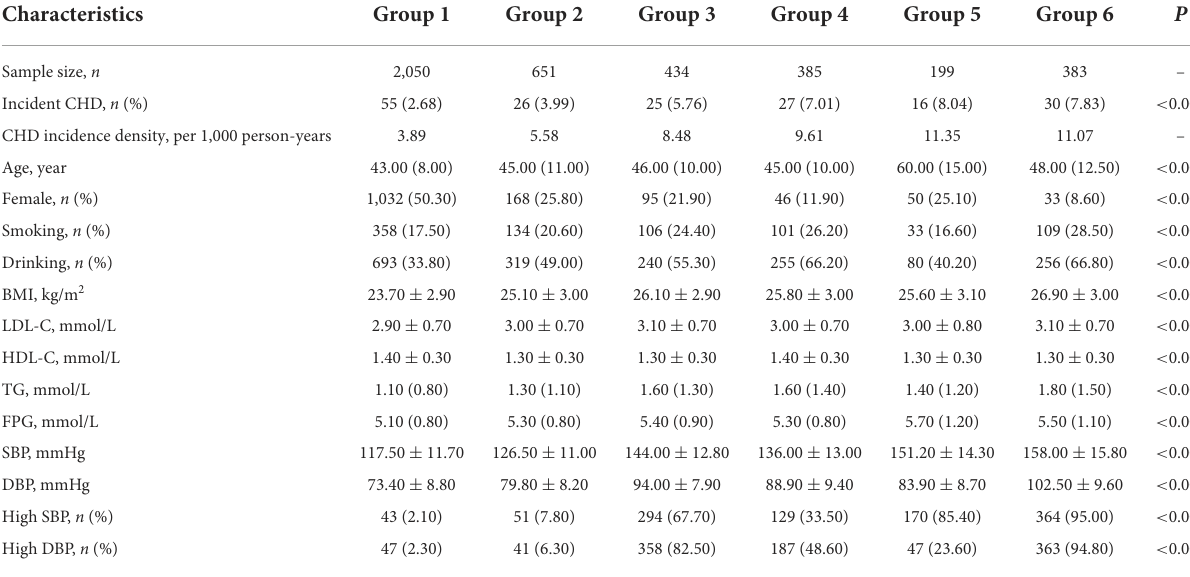
TABLE 1 Baseline characteristics grouped by different multi-trajectories of systolic and diastolic hypertension.